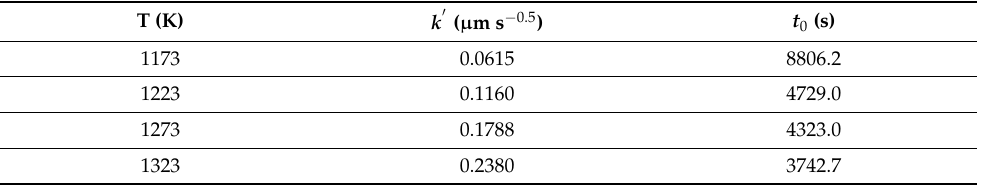
Table 2. New kinetics constants at the ( FeB / Fe 2 B ) interface with respect to the boride incubation times t 0